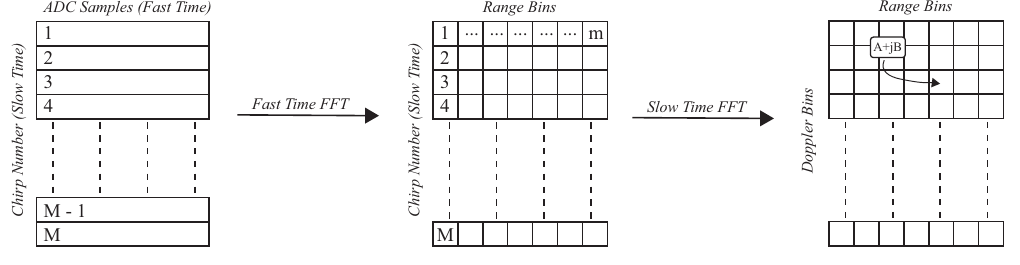
Figure 5. Range-Doppler Map data